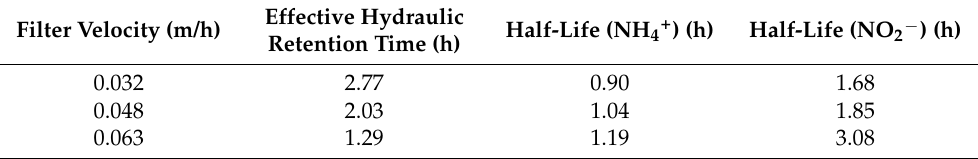
− depending on the filter velocity and effective hy- 2